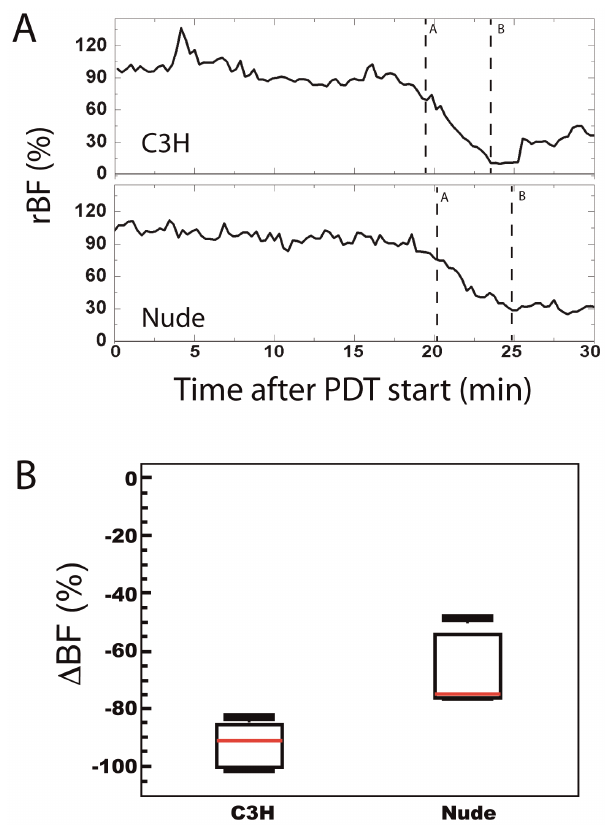
Figure 1. Strain-dependent differences in tumor blood flow during PDT. (A) Representative rBF time-courses in RIF tumors for a C3H and a nude mouse during 30 minutes of illumination with PDT (t=0). The lines A and B represent the change points marking the beginning of the decrease in rBF and the plateau in rBF level, respectively, and were used to define the change in rBF (i.e. D BF=rBF A 2 rBF B ). (B) Box plots of blood flow changes ( D BF) during PDT within animals of each strain (N=7 for each strain); PDT decreased rBF in both groups (p=0.016 for both C3H and nudes), with the decrease in C3H larger than that in nudes